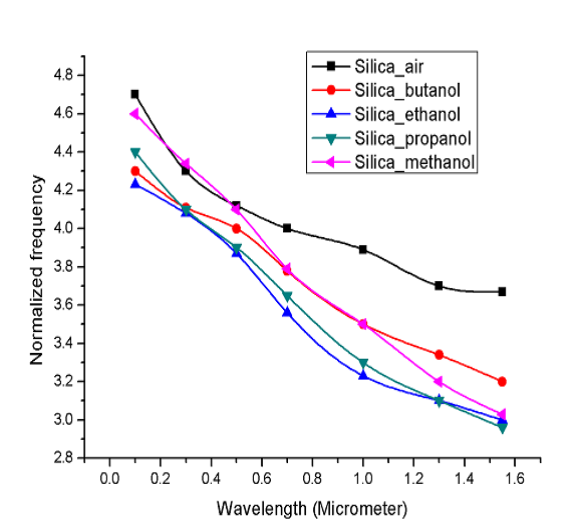
Figure 6: Normalized